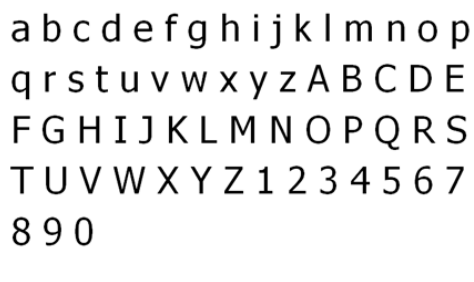
FIGURE V. SAMPLE OF DATASETS